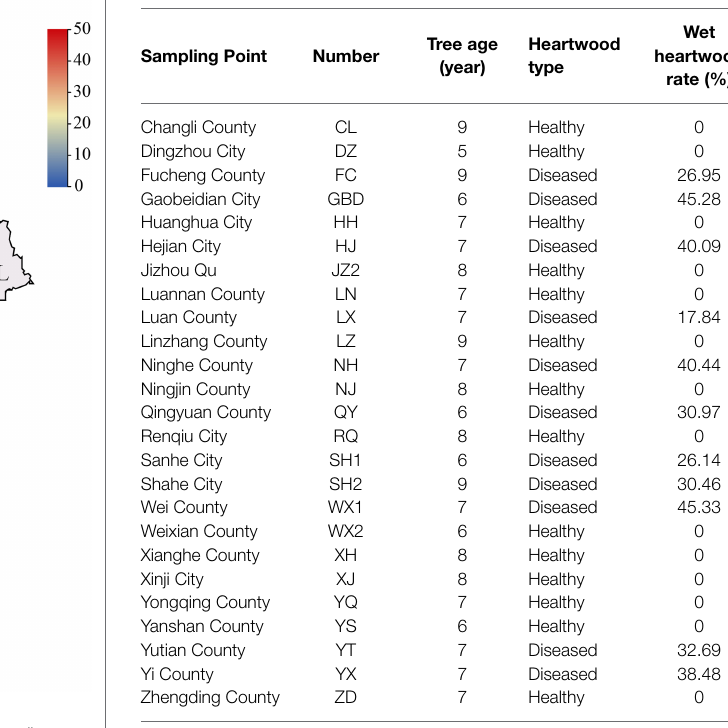
TABLE 1 | Sample information and wet heartwood